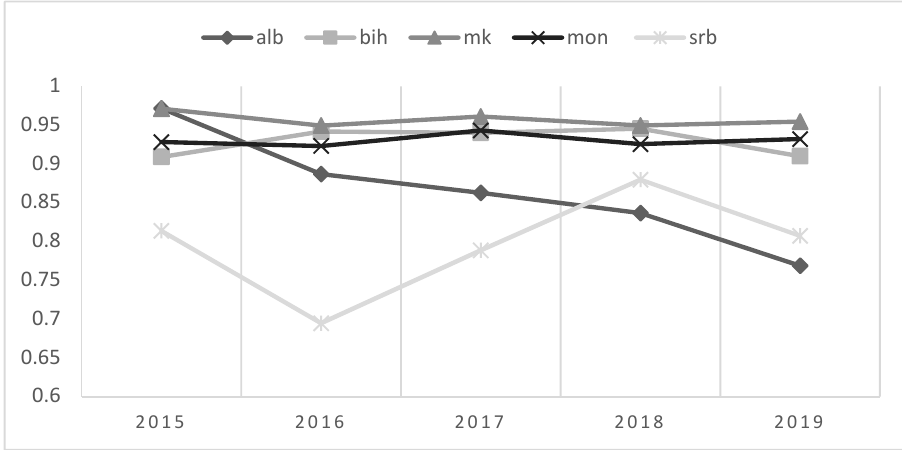
Figure 2. Average Efficiency Score per year, per country. Source: Authors’ calculations .